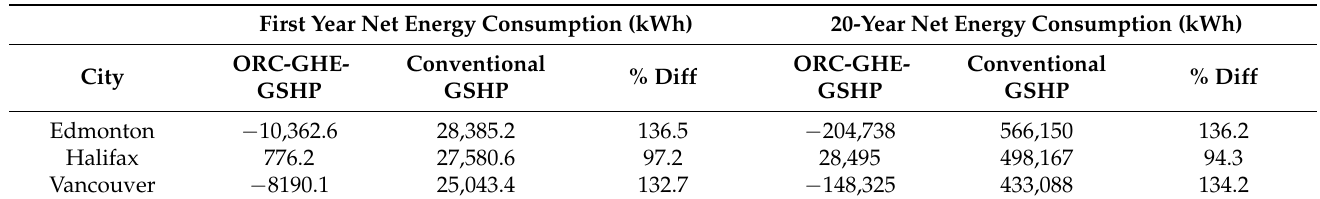
Table 6. Net energy consumption for the first year and after 20 years for each system and city. First Year Net Energy Consumption (kWh)